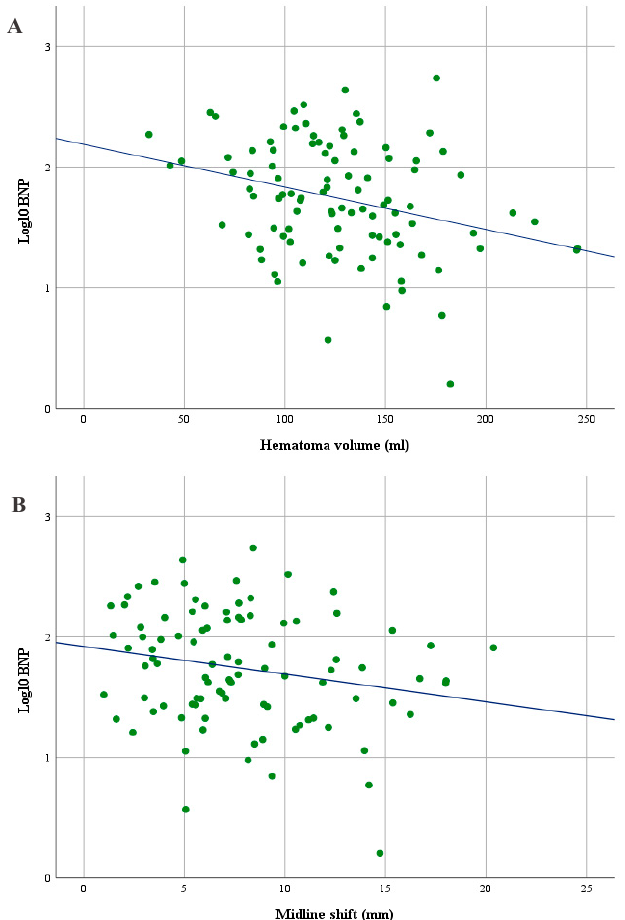
Figure 2. Scatterplot showing an inverse linear relationship between hematoma volumes and log 10 brain natriuretic peptide serum levels (BNP) ( A ) and between midline shift (MLS) and log 10 BNP ( B ) in patients with symptomatic cSDH. Table 3. Relationship between BNP and clinical and radiographic parameters.